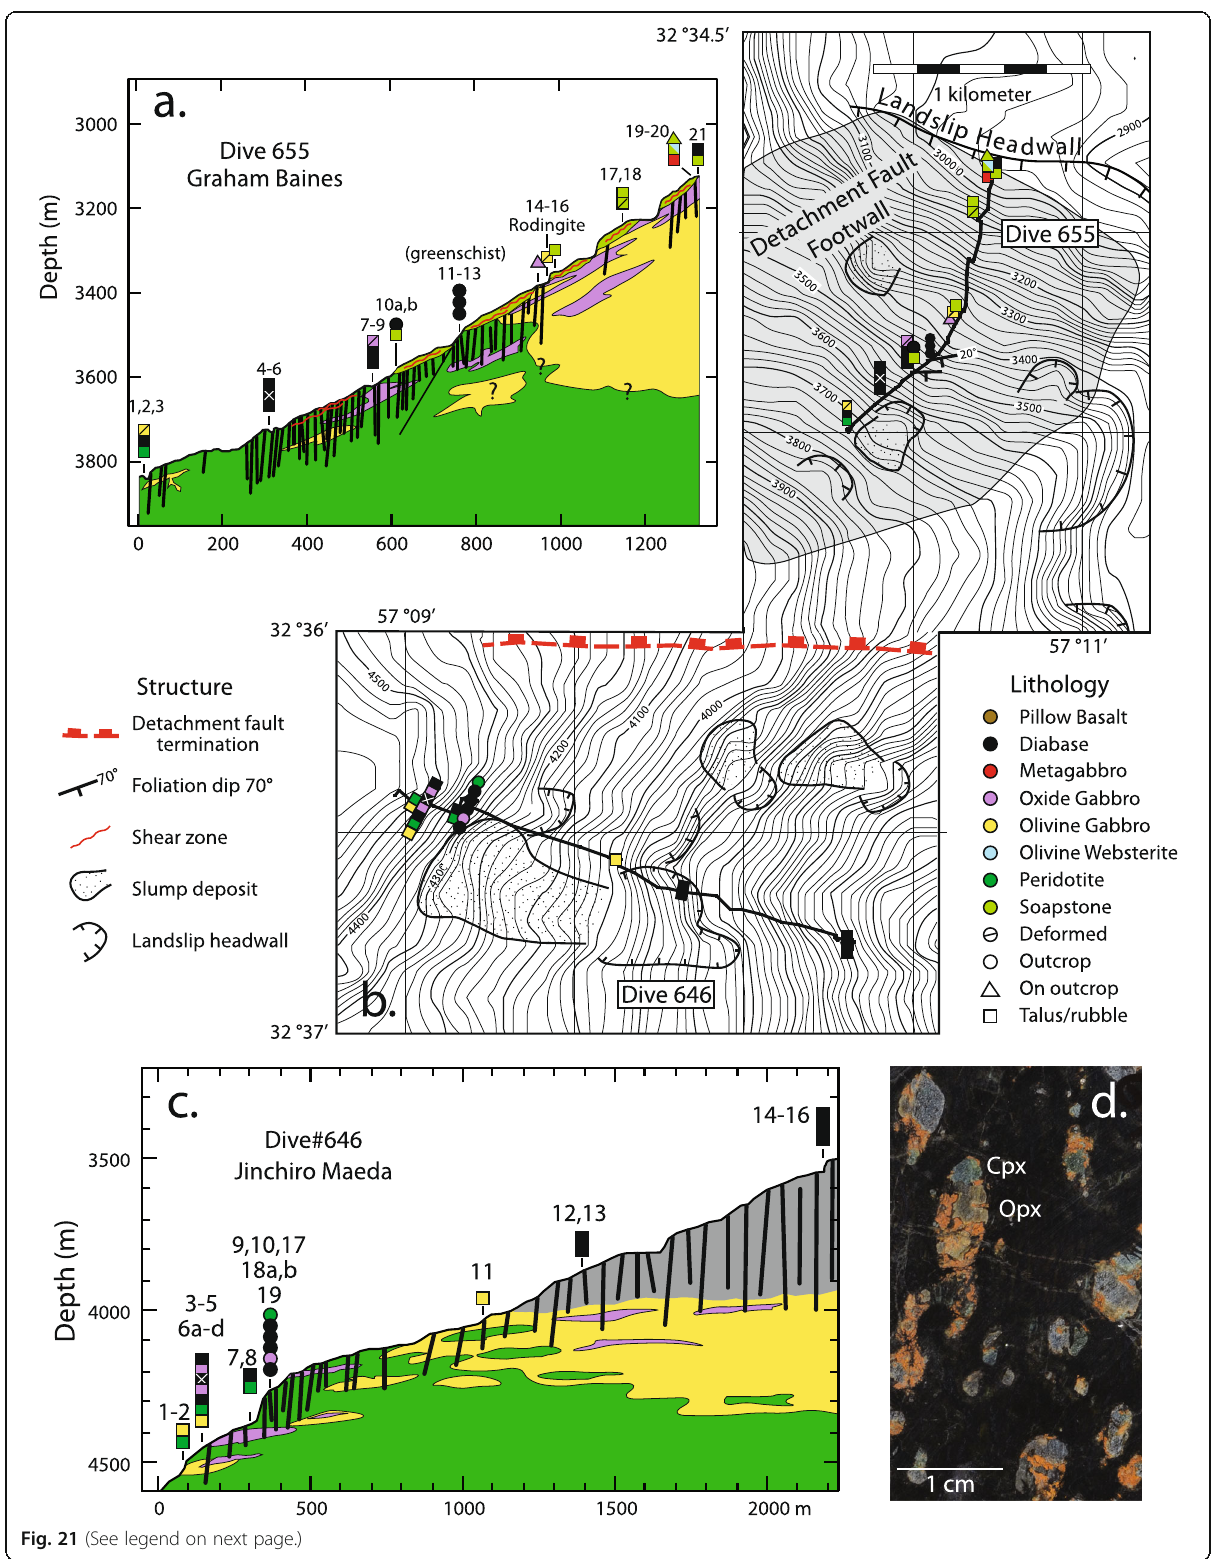
Fig. 21 (See legend on next